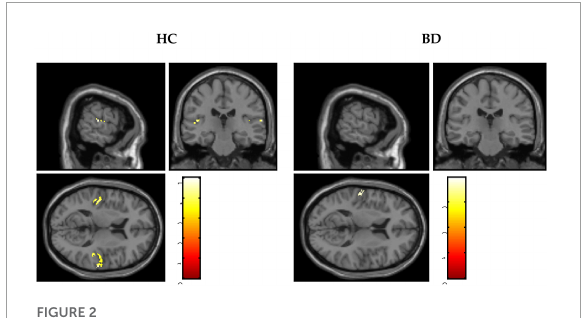
FIGURE2 Blood oxygen level-dependent (BOLD) signals activated by 40-Hz click stimuli in the healthy controls (HC) group and the bipolar disorder (BD) group compared with the resting